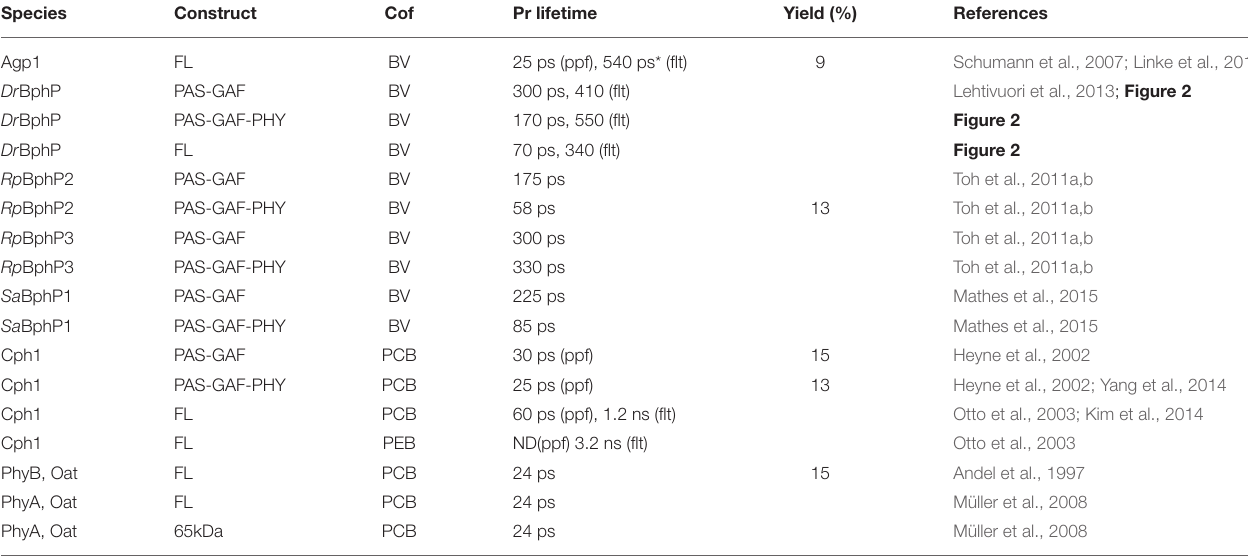
TABLE 1 | Excited state lifetimes of phytochrome systems from various species.